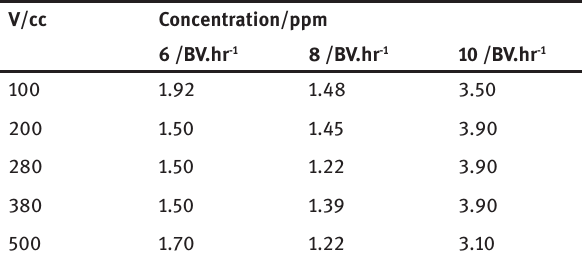
Table 3: Results bed flow and its impact on reducing the aldehyde concentration from 300 ppm initial concentrations.